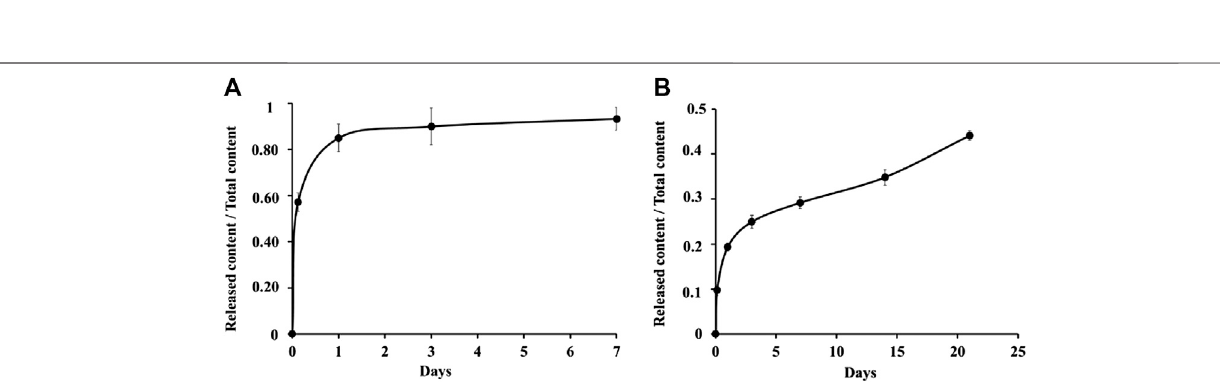
FIGURE 4 | Ion release pro fi le of inorganic phases. (A) MBG_SG_10%Sr nanoparticles; (B) HA_50%Sr. The results are expressed as mean ± SD.